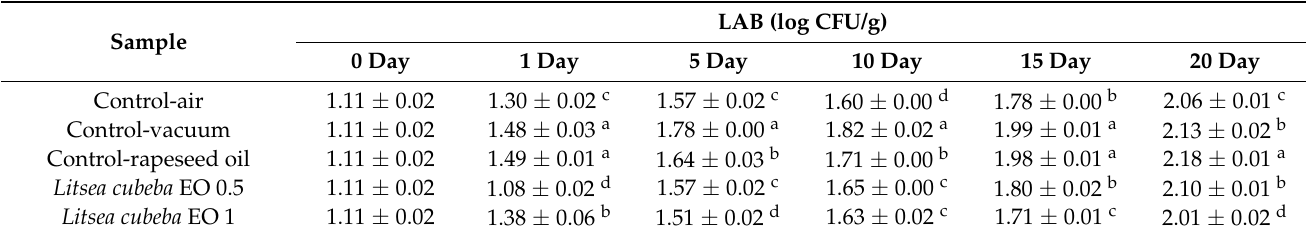
Table 4. Average numbers of lactic acid bacteria (LAB) log CFU/g in samples of deer meat during 20 days of storage at 4 ◦